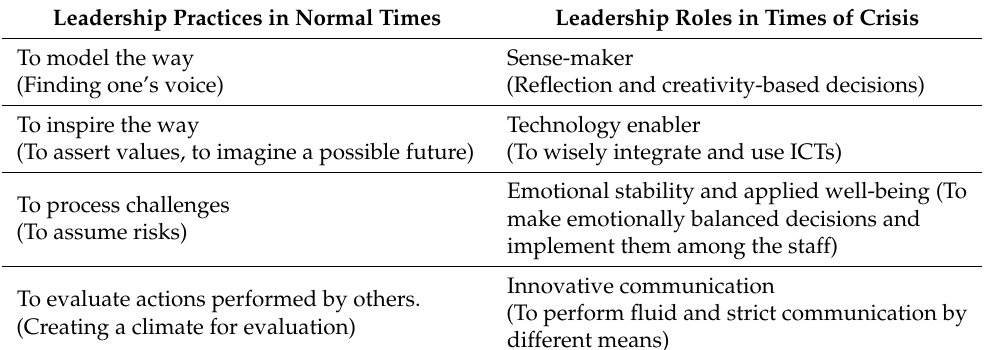
Table 1. Best leadership